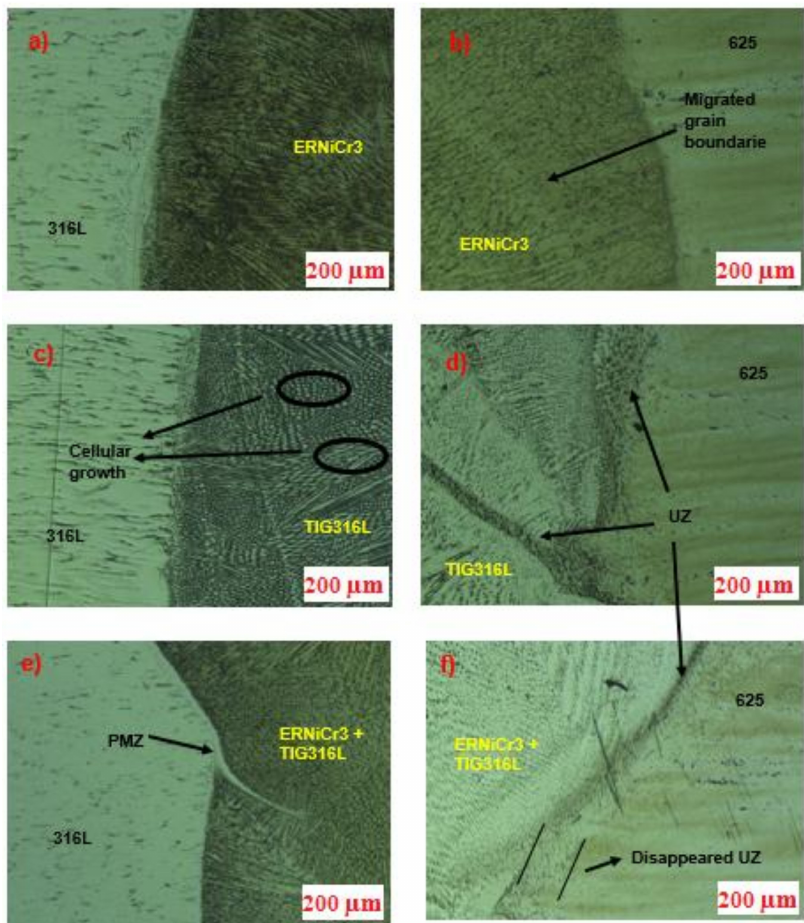
Figure 5. Microstructures of bimetallic joints of Inconel 625 and AISI 316L obtained by PCGTA welding, employing ERNiCr3 ( a , b ), TIG 316L ( c , d ), Twisted Fillers ( e , f